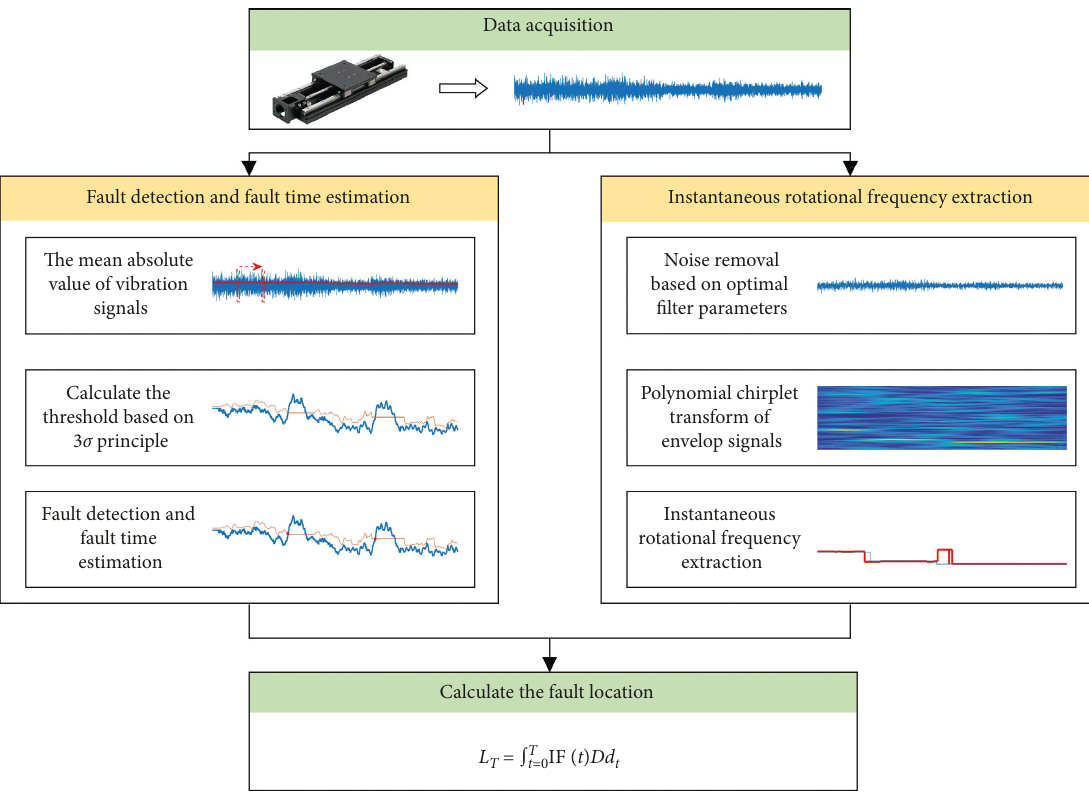
Figure 2: Flowchart of the proposed